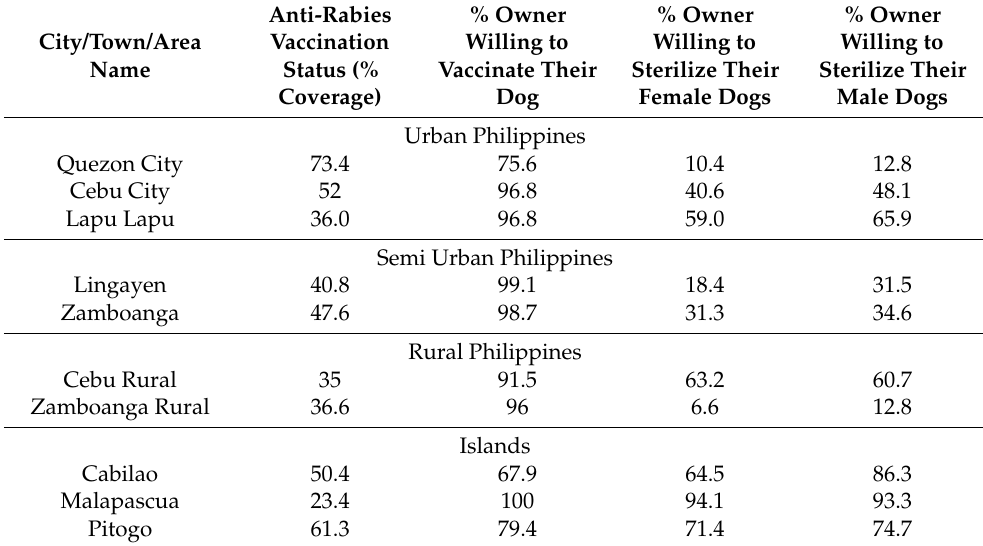
Table 2. Willingness of dog owners to vaccinate and sterilize their pet dogs.